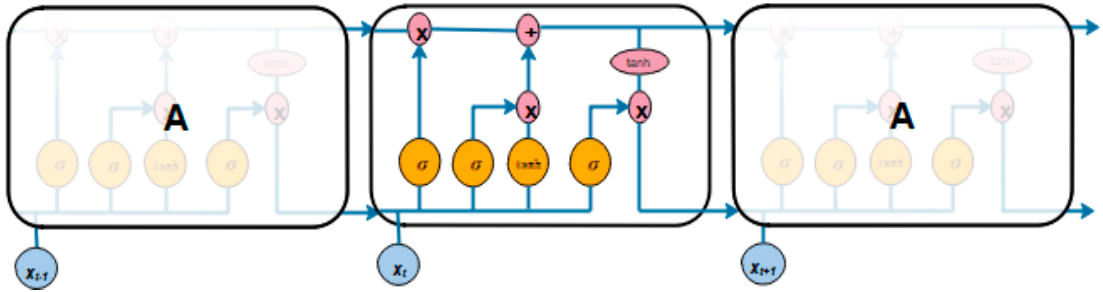
Figure 1. The interaction between Long Short-Term Memory layers.